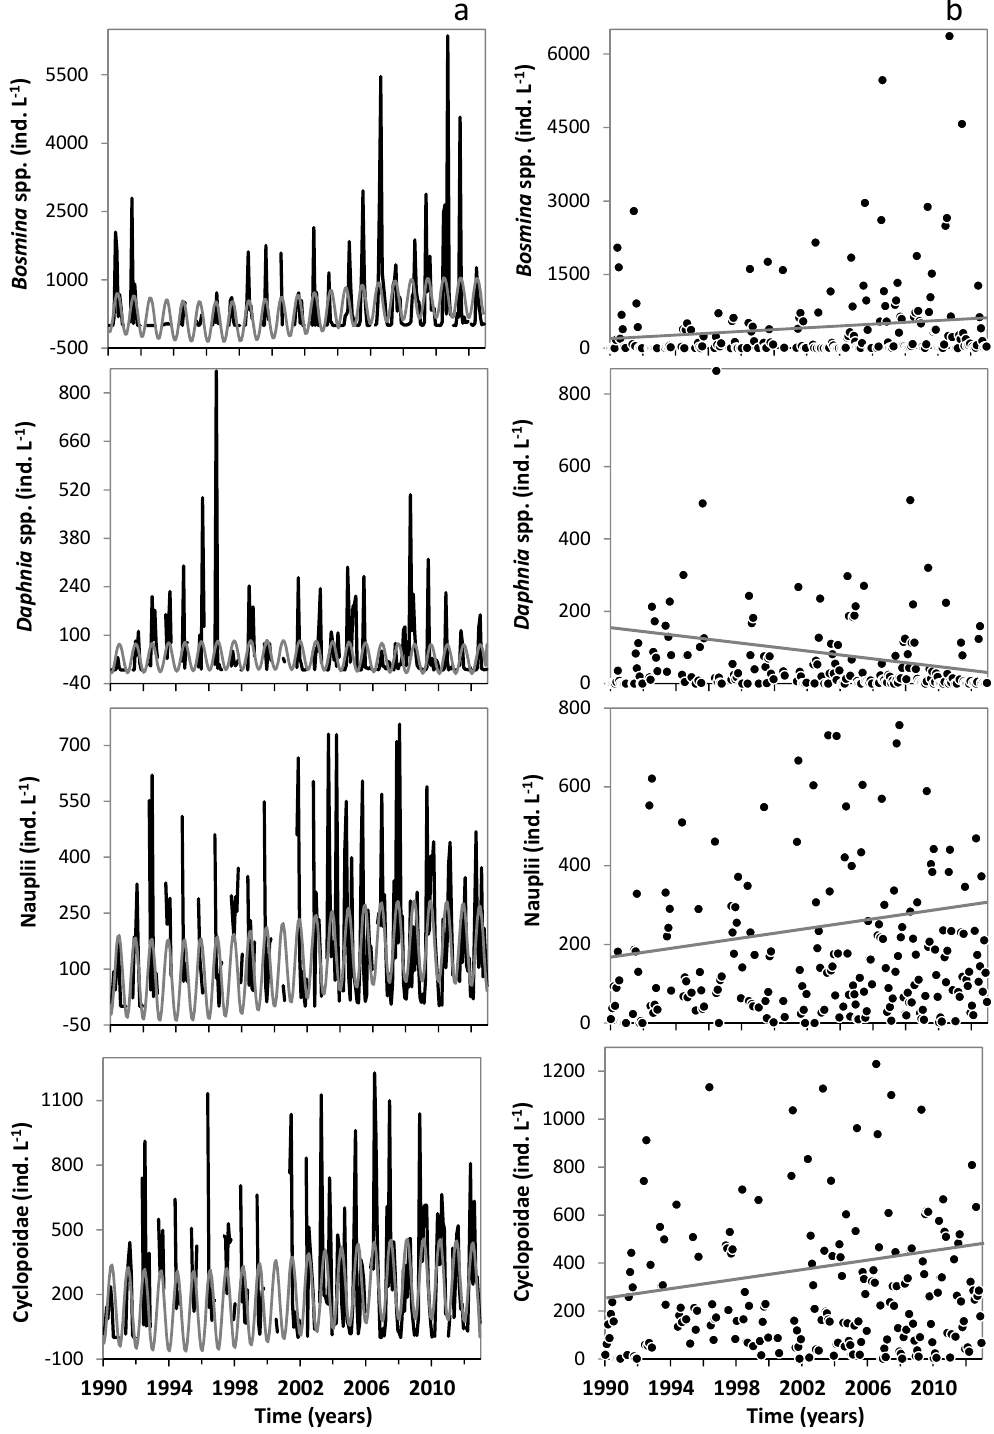
Figure 5. Temporal variations in Bosmina spp., Daphnia spp., nauplii and adult Cyclopoidae in Lake Søbygaard region during the 23 years of study (1990–2012). Sinusoidal fit (grey) ( a ) and GLM ( b ) regression lines are shown.